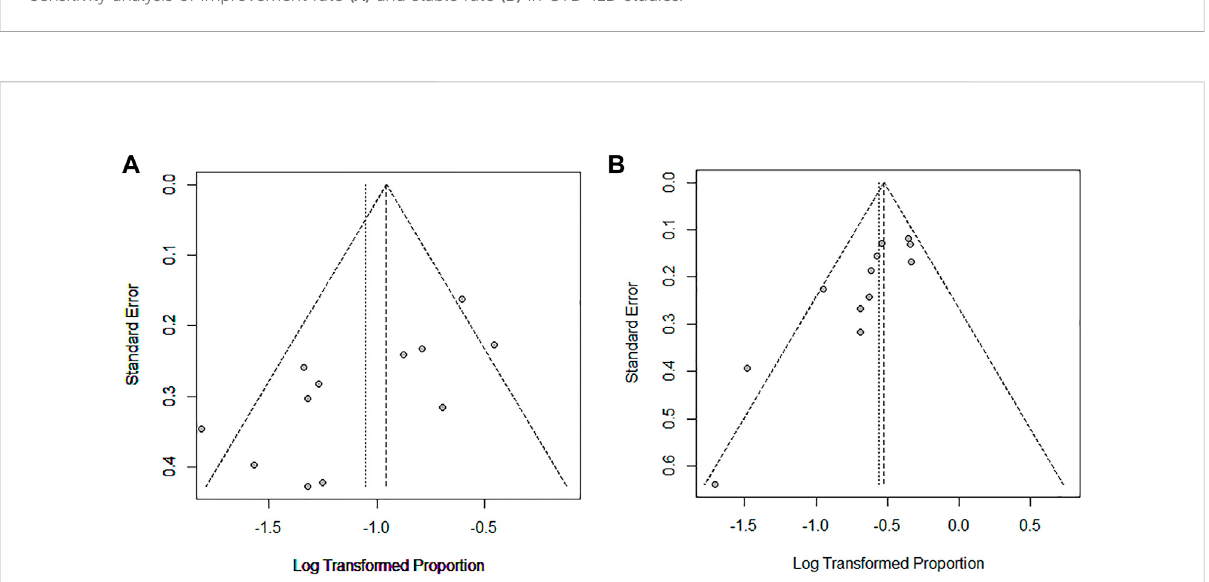
FIGURE 5 Egger funnel plot of improvement rate (A) and stable rate (B) in CTD-ILD studies.